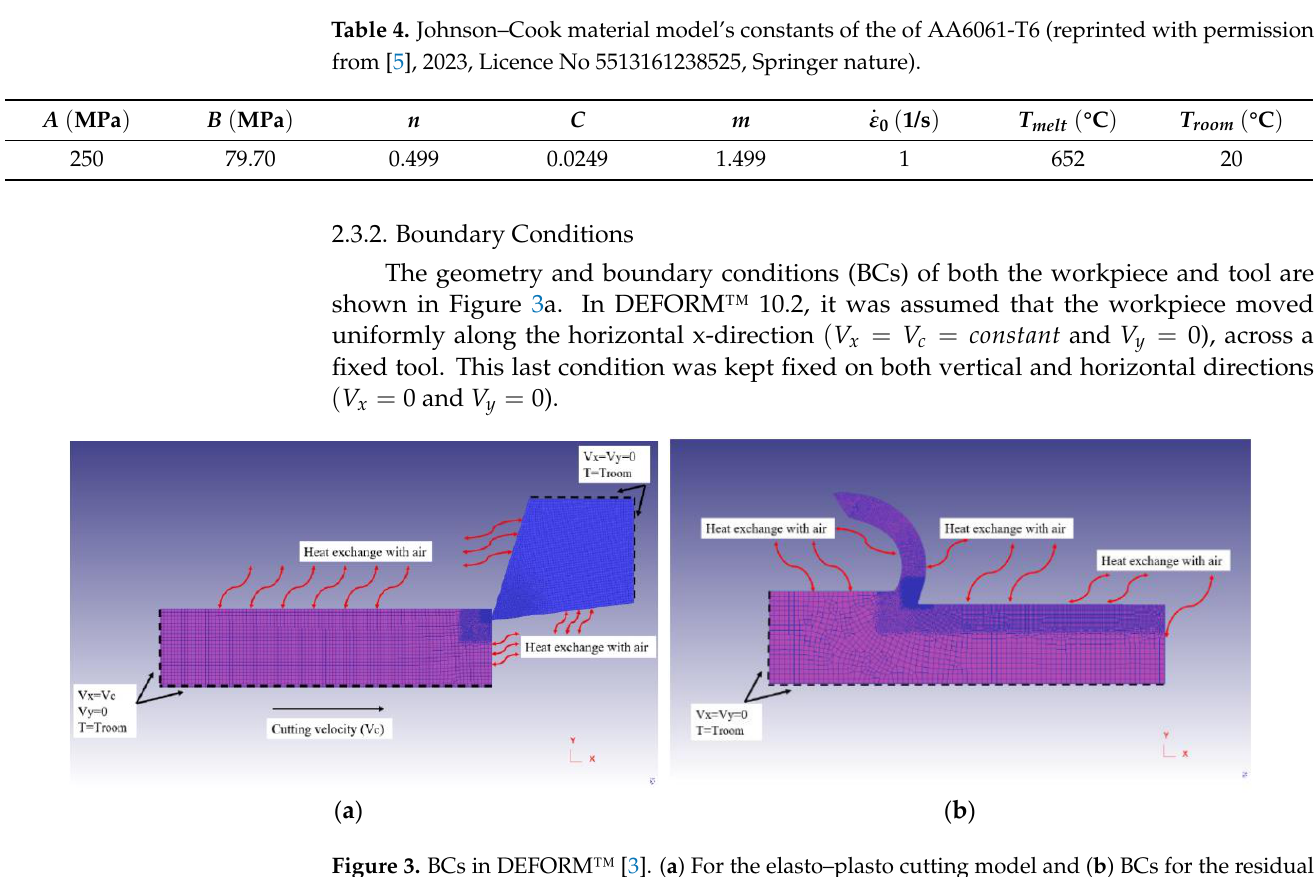
Table 3. Cutting conditions and tool geometry parameters.